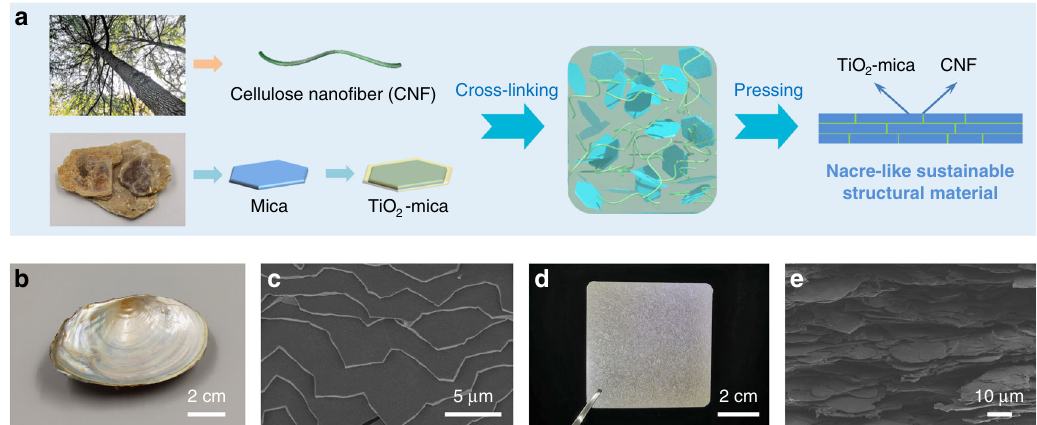
Fig. 1 Fabrication and characterization of all-natural bioinspired structural material. a Schematic illustration of directional deforming assembly method to manufacture all-natural bioinspired high-performance structural material. b Anodonta woodiana . c Fracture surface of Anodonta woodiana . d All-natural bioinspired structural material. e Fracture surface of all-natural bioinspired structural